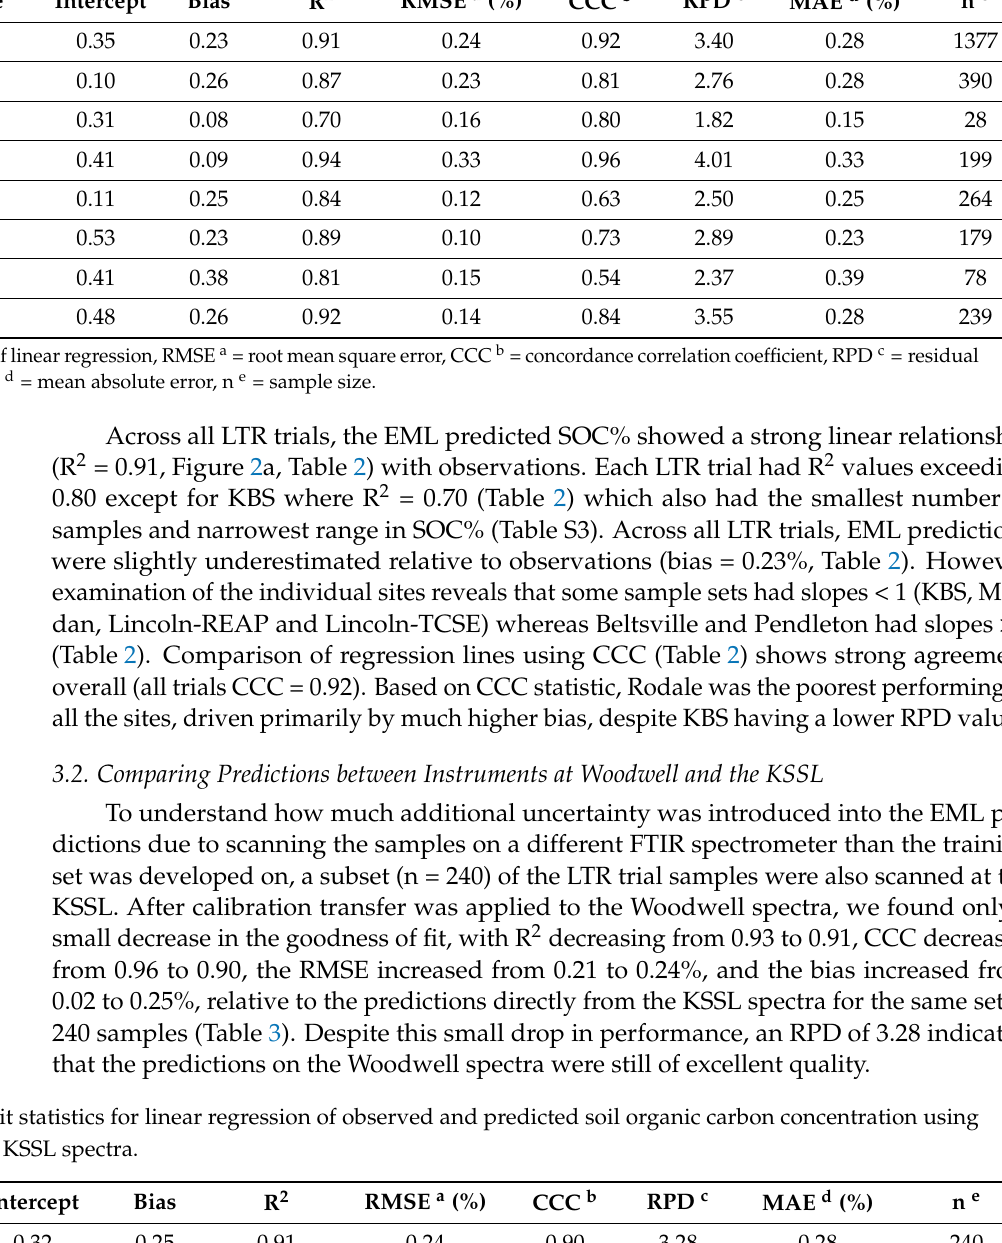
Table 2. Linear regression of observed and EML predicted using Woodwell spectra for all trials combined and subset by trial.